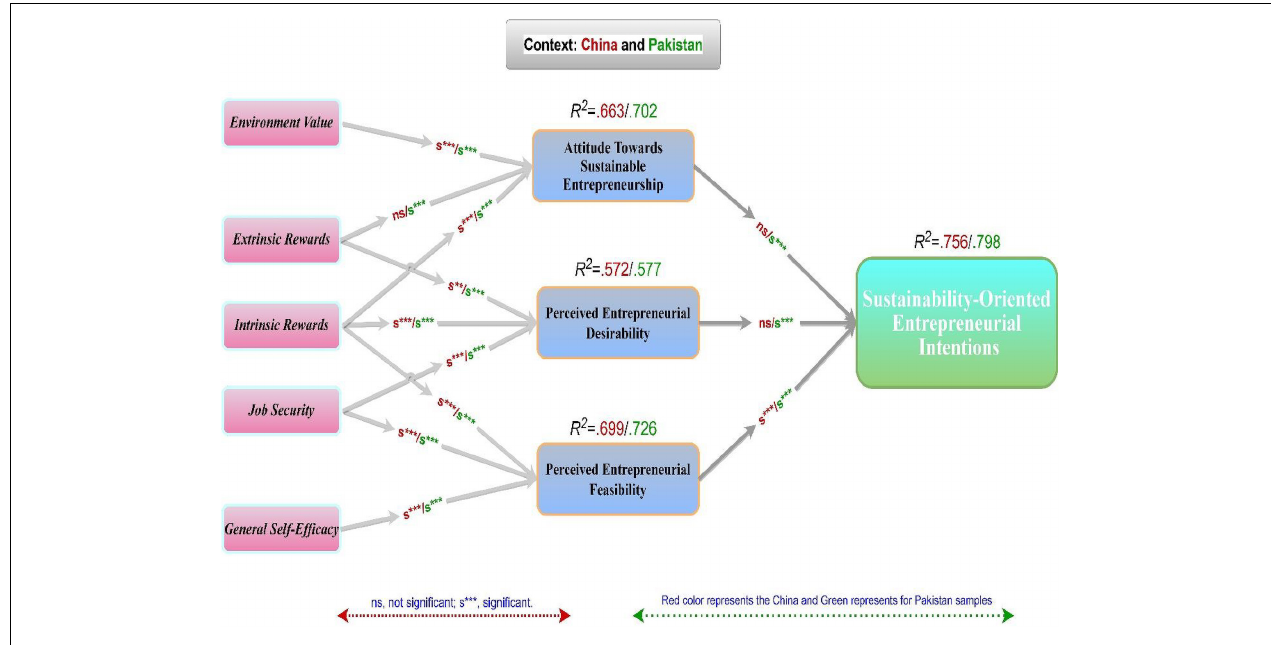
FIGURE 2 | Results of the structural model linking work values and TPB to SEI.